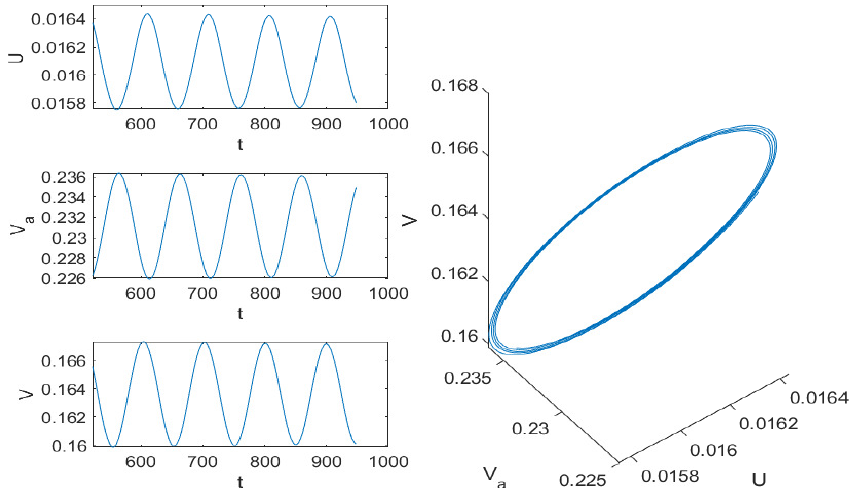
Figure 5. When τ = 38.4, the periodic solution of system (1) near equilibrium P is